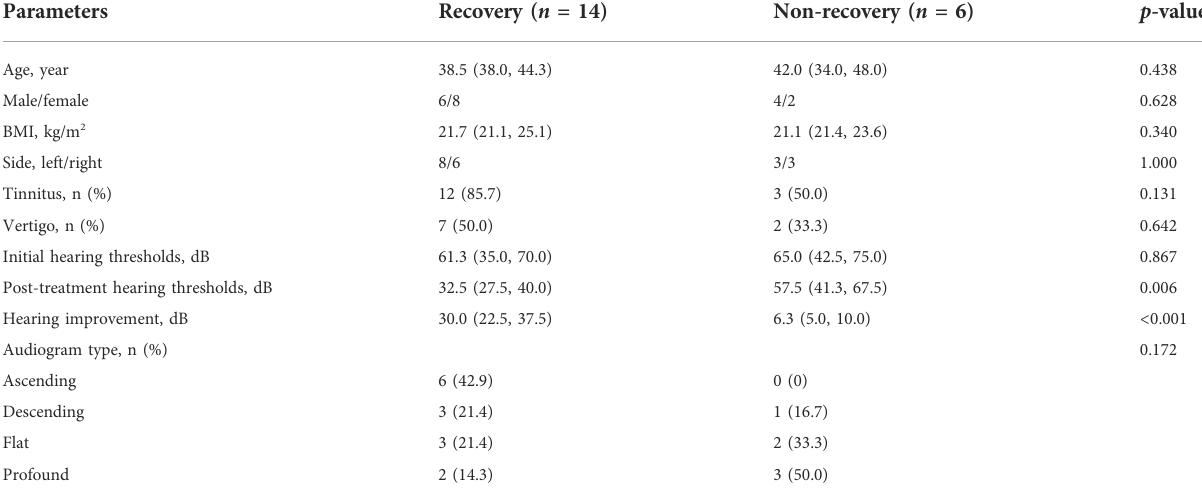
TABLE 3 Demographic and clinical parameters between recovery and non-recovery